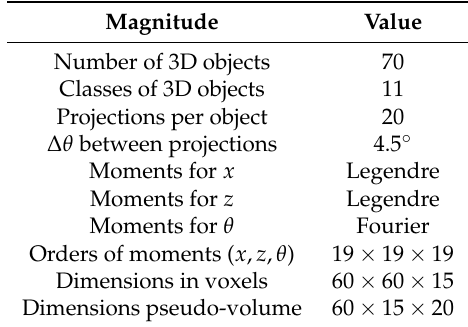
Table 1. Summary of data